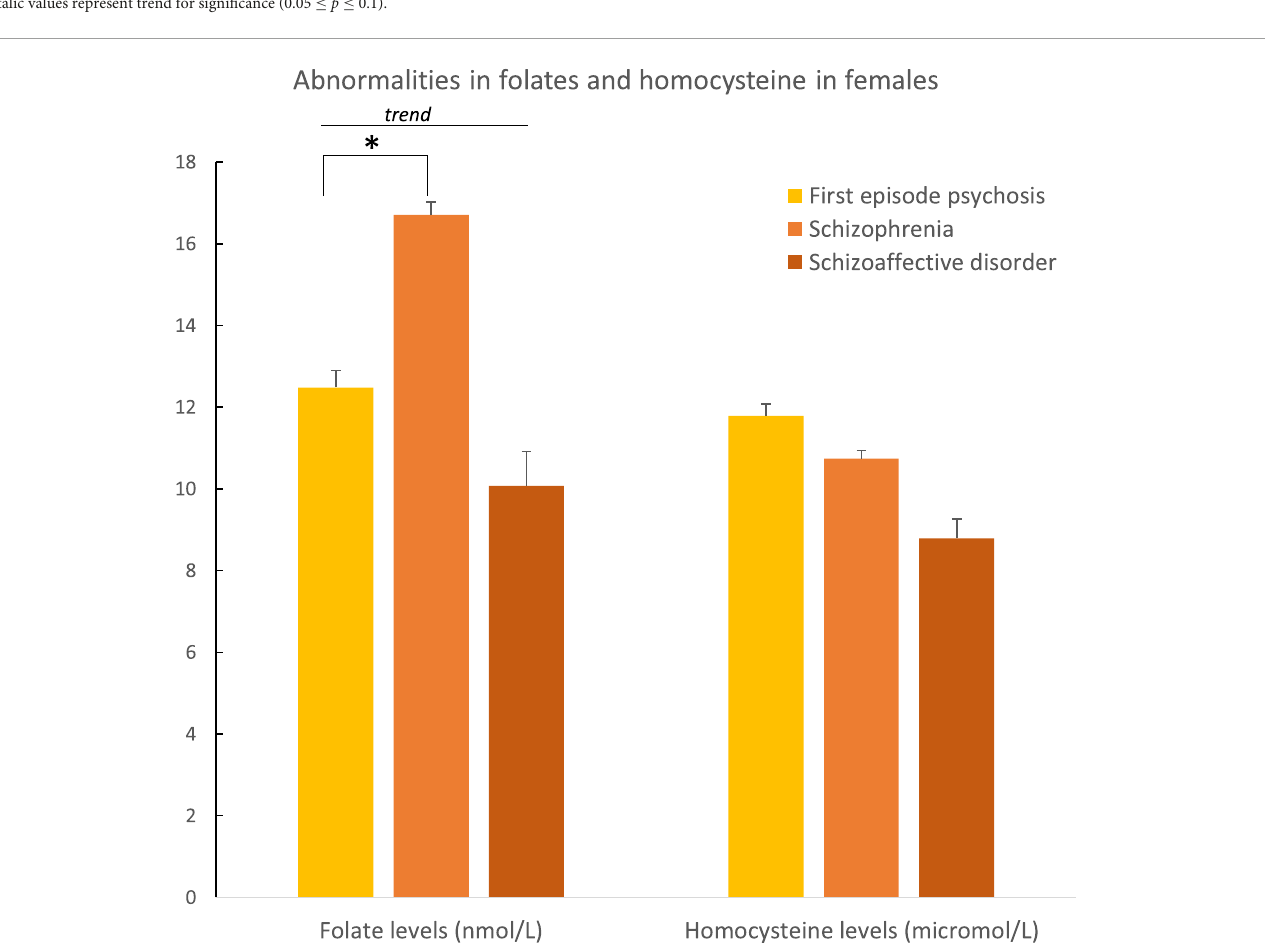
differences between the three groups had a p = 0.04, Table 3